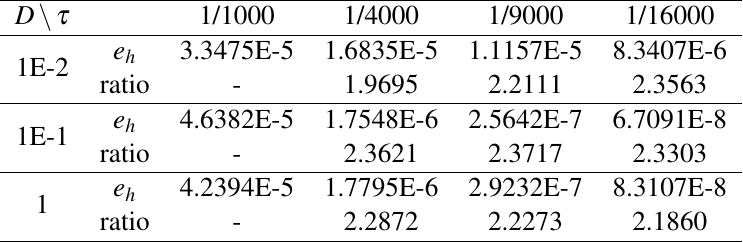
Table 2 Errors and ratios of convergence in time for different diffusion D .